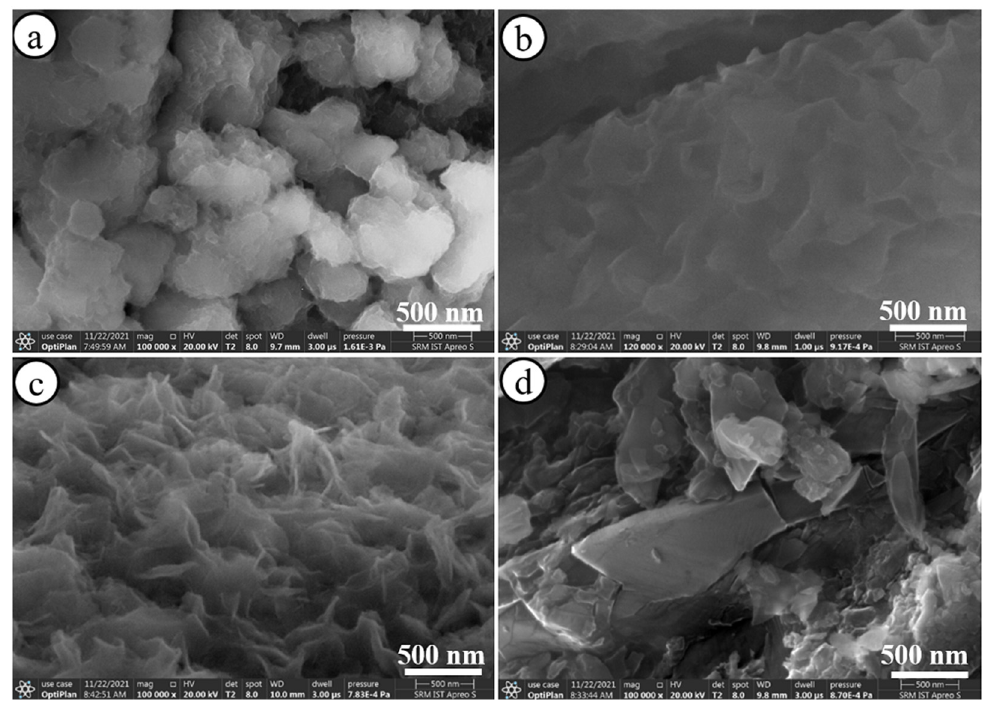
Figure 2. HR ‐ SEM images of the PS ‐ 3D ‐ FeP@NiO|Ni ( a ), CoP@NiO ǀ Ni ( b ), NiP@NiO ǀ Ni ( c ), and Figure 2. HR-SEM images of the PS-3D-FeP@NiO|Ni ( a ), CoP@NiO|Ni ( b ), NiP@NiO|Ni ( c ), and CuP@NiO ǀ Ni ( d ) nanostructured electrodes. CuP@NiO|Ni ( d ) nanostructured